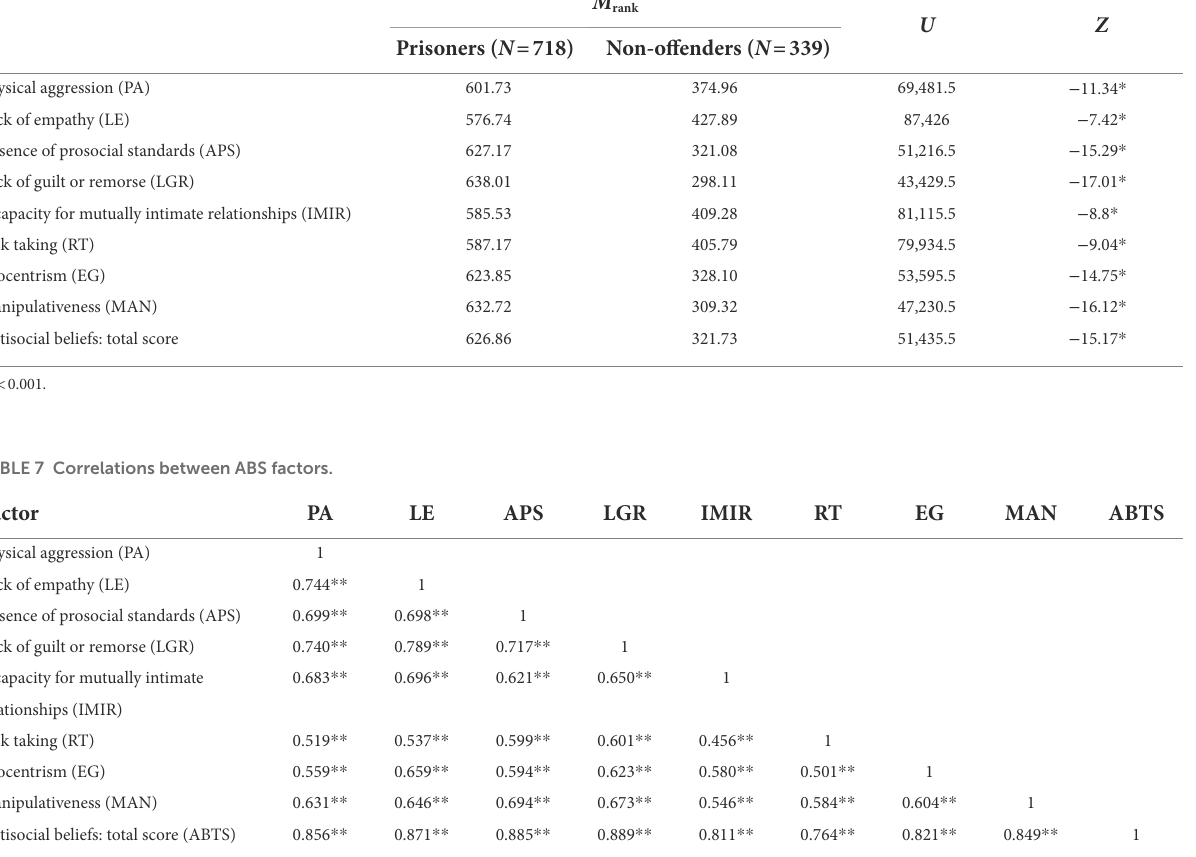
TABLE 6 Differences between prisoners and non-offenders in ABS dimensions.